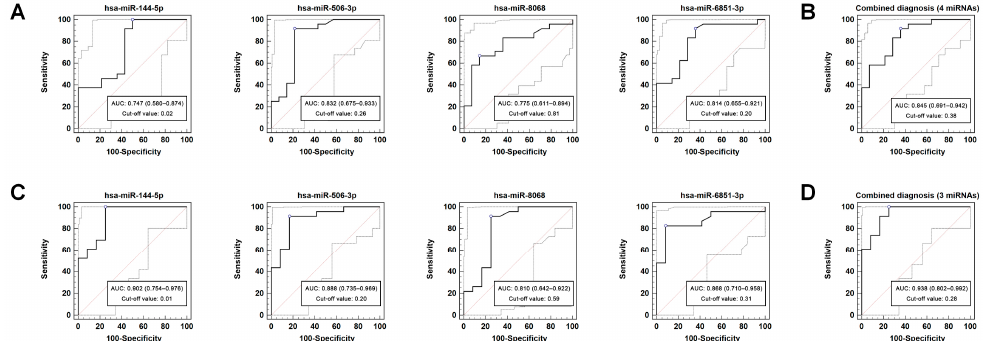
Figure 3. ROC curve of key miRNAs for PMOP diagnosis. ( A ) Independent diagnostic performance of individual miRNAs in the training set. ( B ) Combined diagnosis using 4 key miRNAs showed the highest accuracy in the training set. ( C ) Independent diagnostic performance of individual miRNAs in the validation set. ( D ) Combined diagnosis using 3 key miRNAs (hsa-miR-144-5p, hsa-miR-506-3p, and hsa-miR-6851-3p) showed the highest accuracy in the validation set. ROC, receiver operating characteristic; PMOP, postmenopausal osteoporosis; and AUC, area under the